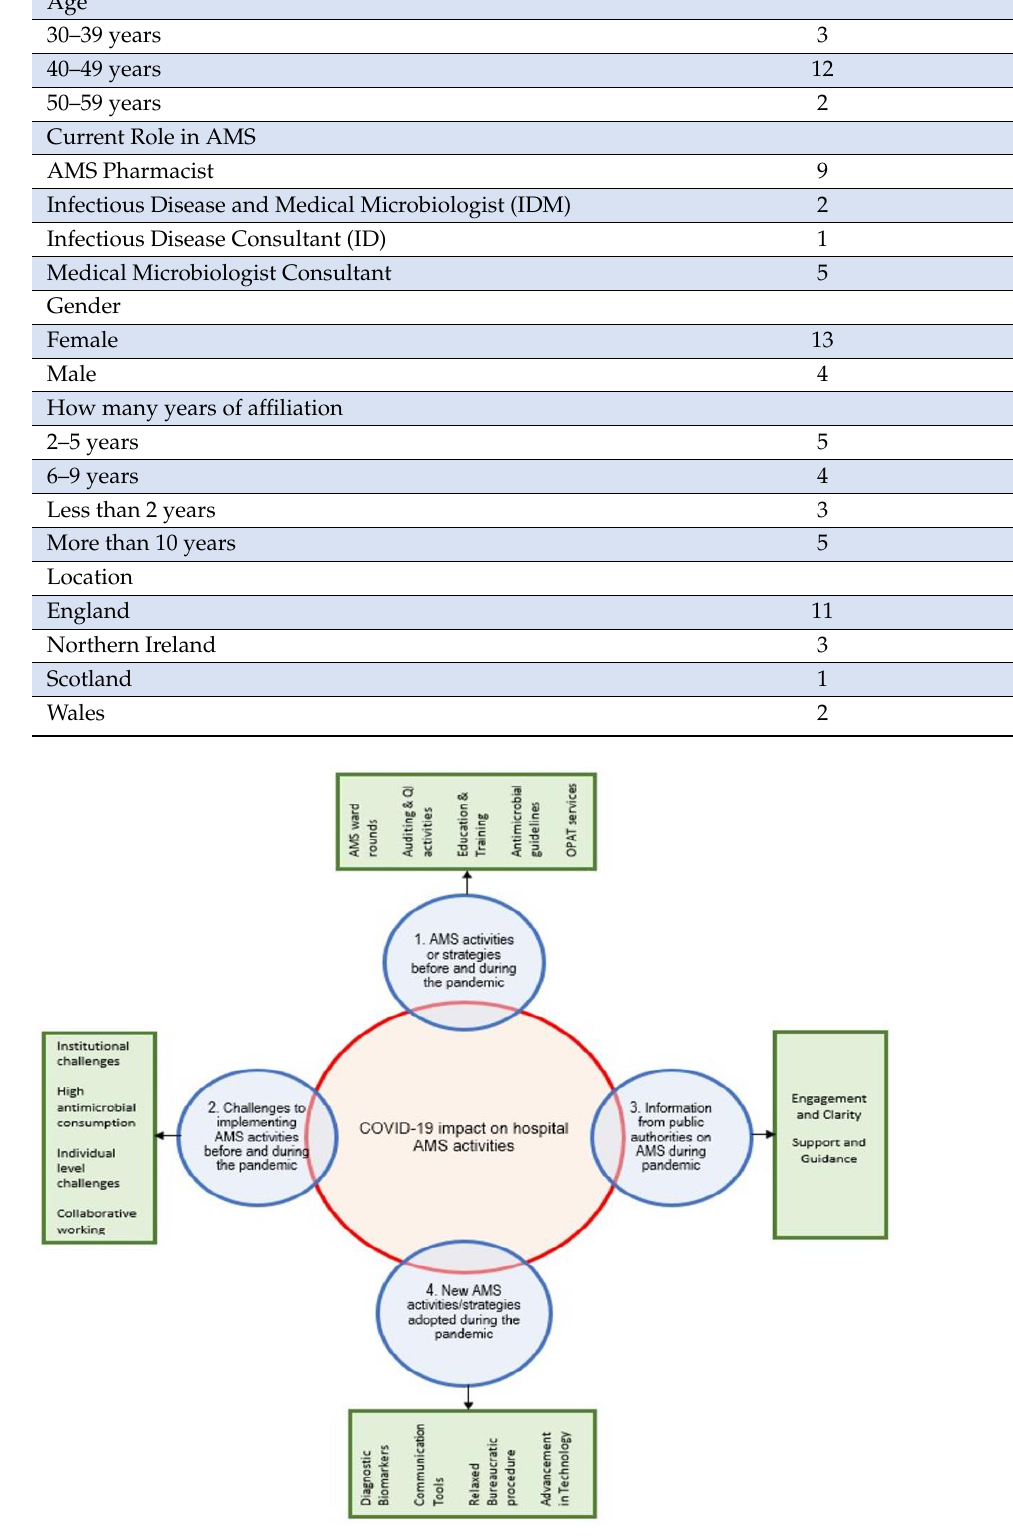
Figure 1. Themes (blue) and subthemes (green) emerged from the qualitative data.